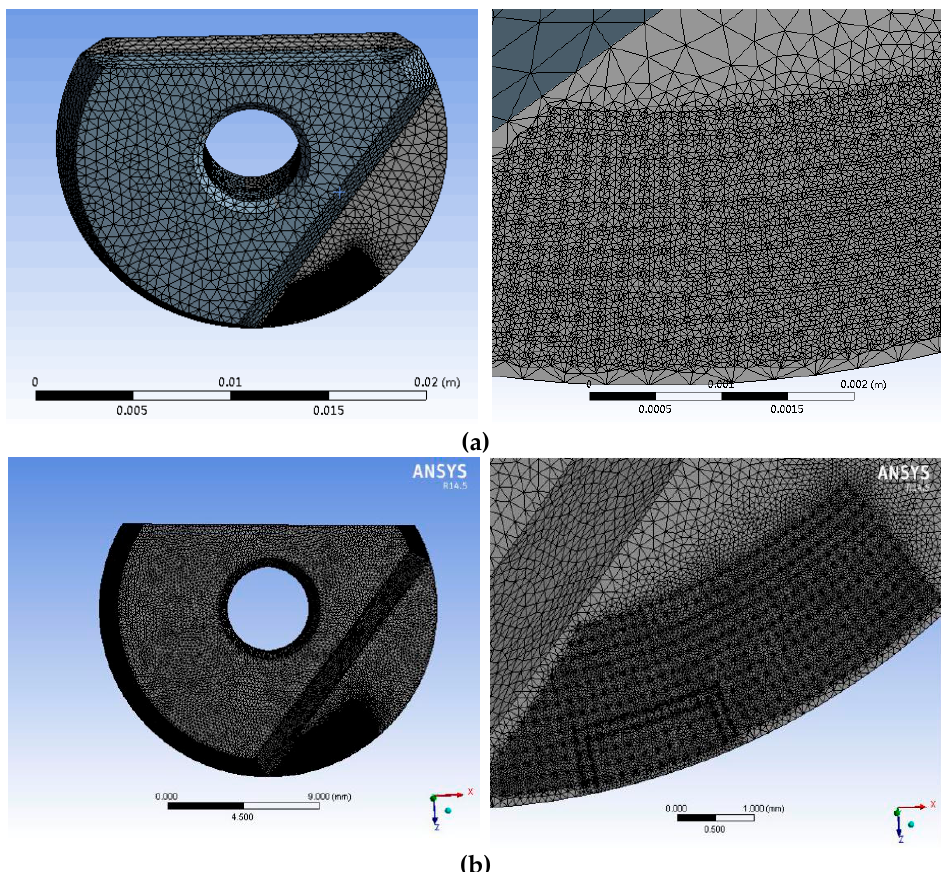
Figure 9. Mesh generation. ( a ) The mesh before optimization. ( b ) The optimized mesh